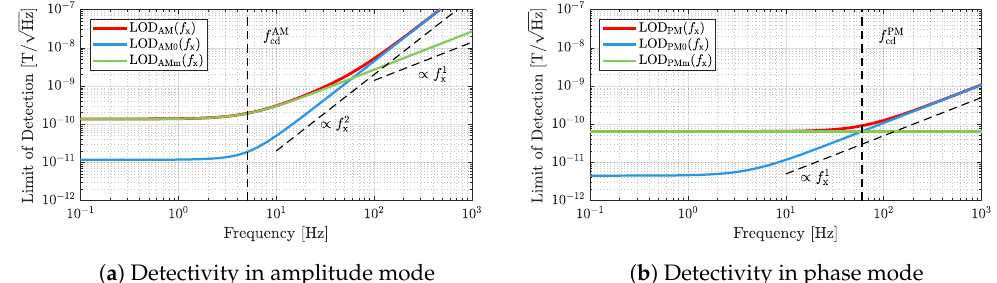
Figure 8. Illustrations of the limits of detection in AM mode ( a ) and in PM mode ( b ). For both types of operation, the low-frequency detectivity is limited by the thermal mechanical noise of the resonator. The bandwidth in which the detectivity is constant with frequency is significantly higher in PM mode. In general, the bandwidth can never be higher in AM mode than in PM mode. In addition, independent of the dominant type of noise, the detectivity in PM mode is always more than 6dB better compared with an operation in AM mode. The plots are based on the sensor parameters given in Table